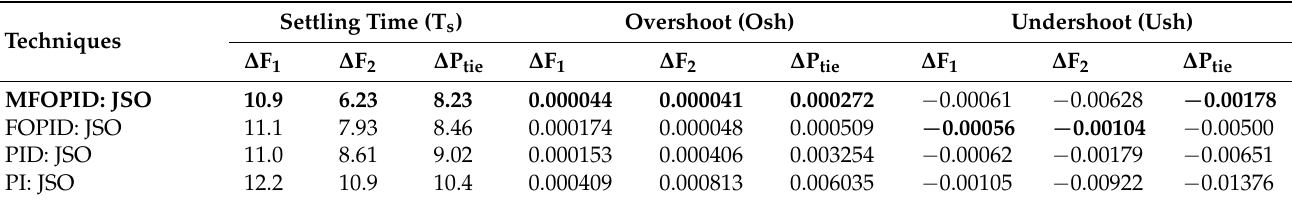
Figure 11. Bar graph of percentage improvement considering case 2.